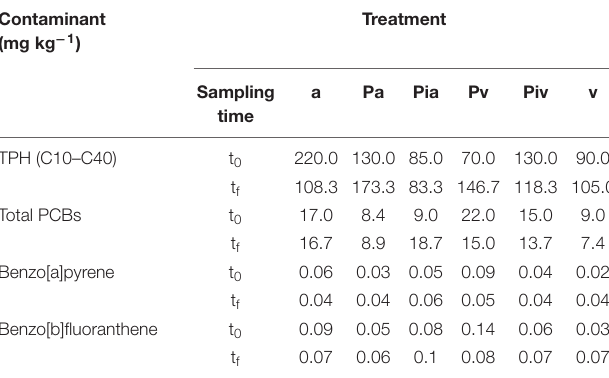
TABLE 2 | Concentration of soil organic